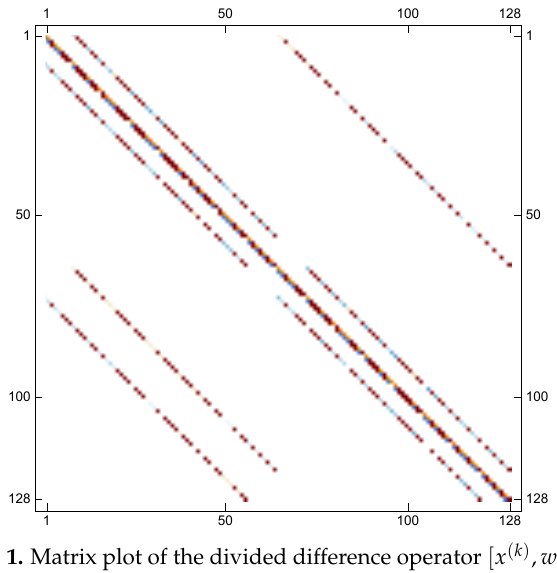
Figure 1. Matrix plot of the divided difference operator [ x ( k ) , w ( k ) ; Ψ ] .